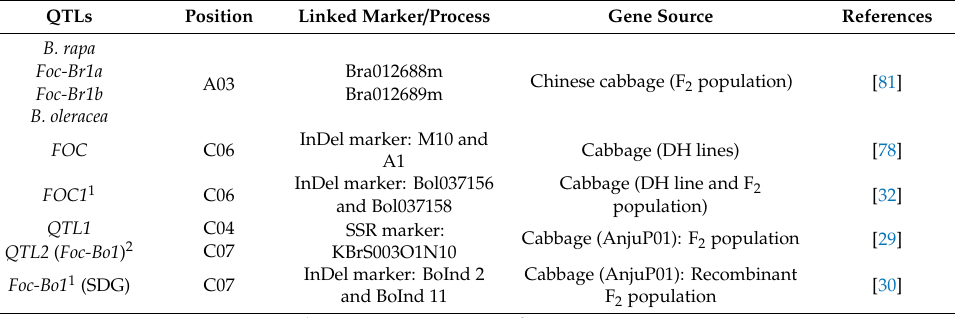
Table 4. Loci of resistance gene to Foc reported in Brassica